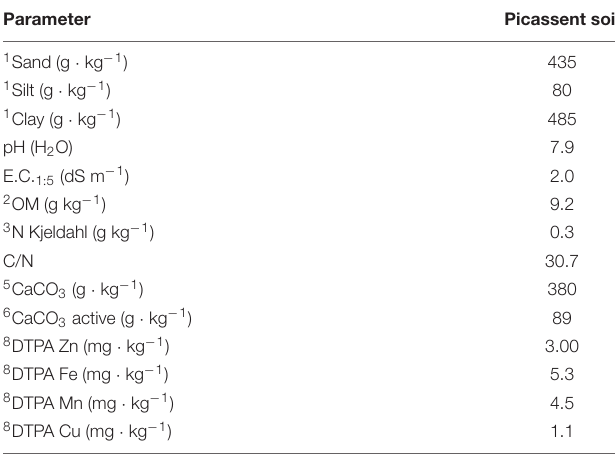
TABLE 1 | Physical and chemical properties of the soil used for both pot